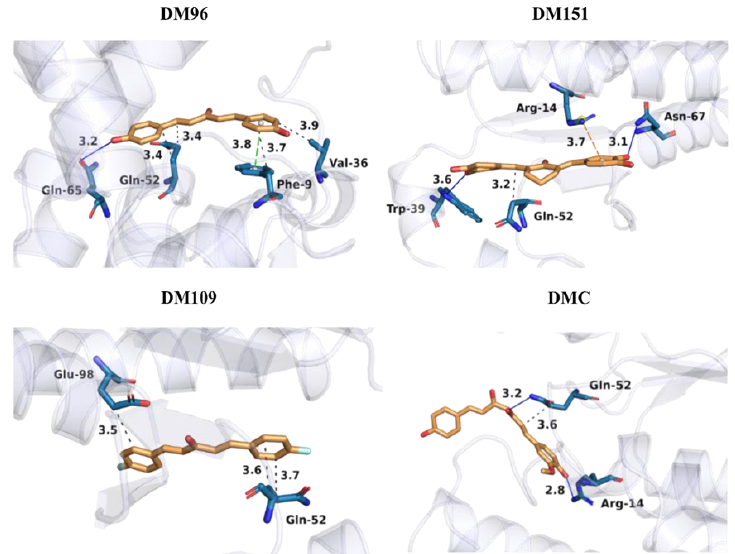
Figure 8. Binding modes of DM96, DM151, DM109, and DMC at the active site of hGSTP1-1. Carbon atoms of the studied curcumin derivatives are presented in orange, while carbon atoms of hGSTP1-1 amino-acid residues are depicted in light blue color. Oxygen atoms are red, nitrogen atoms dark blue, and fluorine atoms green. Hydrophobic interactions are presented with gray dashed lines and hydrogen bonds with dark blue lines. All distances represent averages over all MD production run snapshots for each complex and are provided in Å . Hydrogen atoms are omitted for reasons of clarity.